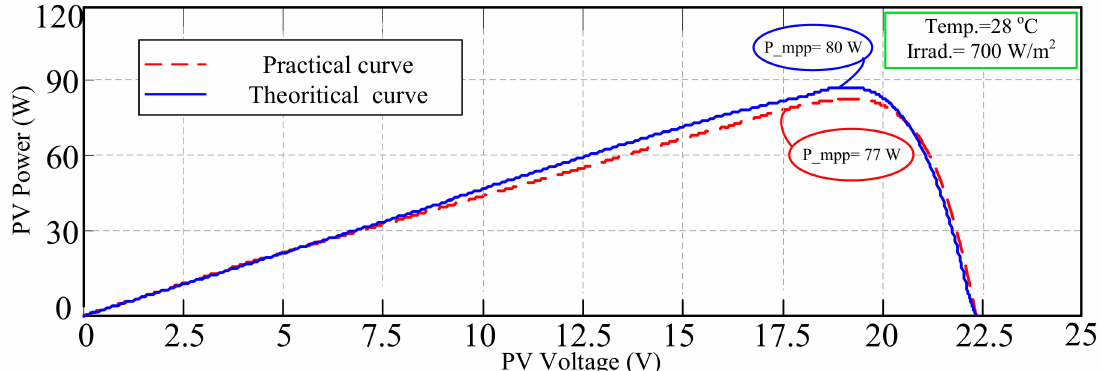
Figure 16. Practical and theoretical curves of the PV module at 80 W.